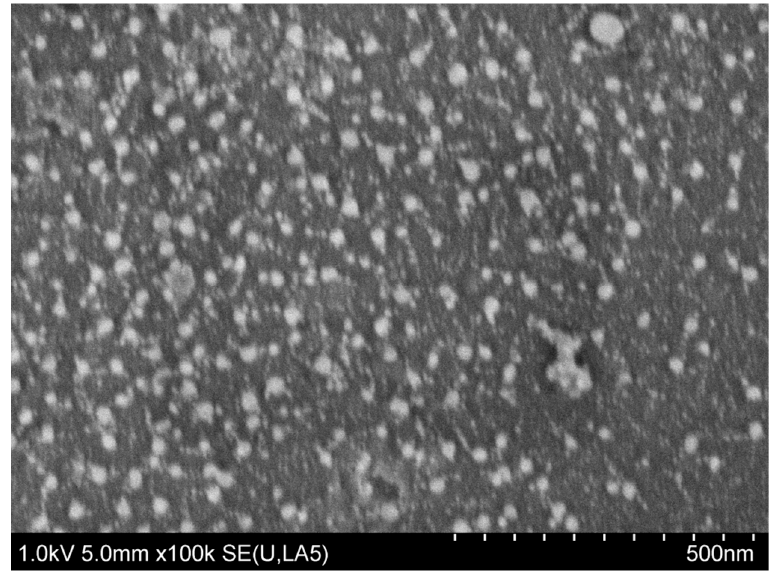
Figure 6. SEM image of sample #6 (concentration 200 mg/L, frequency 2.4 MHz).